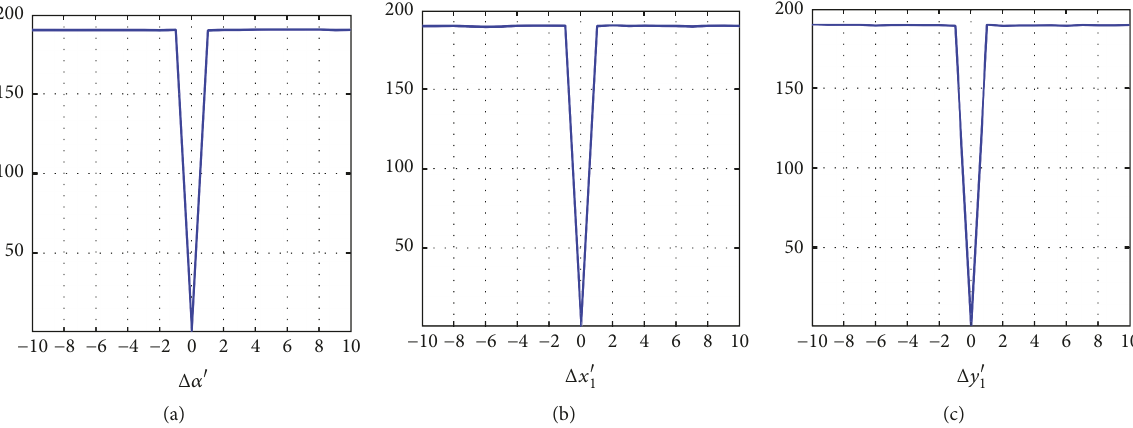
Figure 7: MSE varies with (a) the control parameter 𝛼 󸀠 shift, (b) the initial value 𝑥 󸀠 1 shift, and (c) the initial value 𝑦 󸀠 1